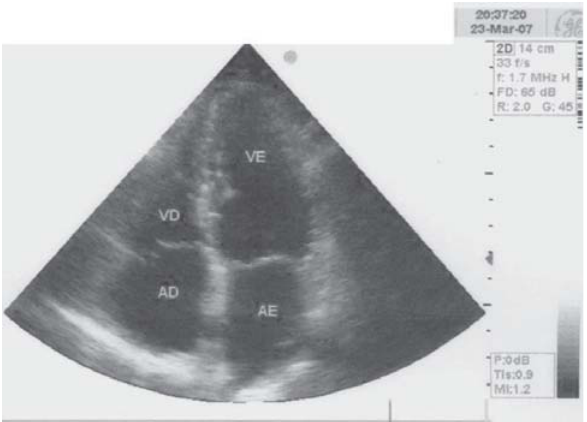
Fig. 4 - Estudo ecocardiográfico de controle, realizado 93 meses após a ressecção da tumoração. Ausência de sinais sugestivos de